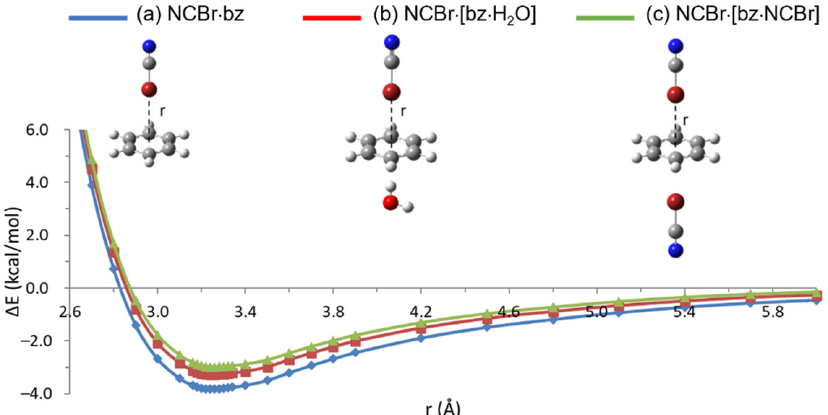
Figure 1. Binding energy curves, Δ E, vs. Br distance from the center of benzene ring, r, computed for ( a ) NCBr·bz (blue line), ( b ) NCBr·[bz·H 2 O] (red line) and ( c ) NCBr·[bz·NCBr] (green line) systems in the T-shaped approach at the M06-2X/aug-cc-PVTZ level of theory.